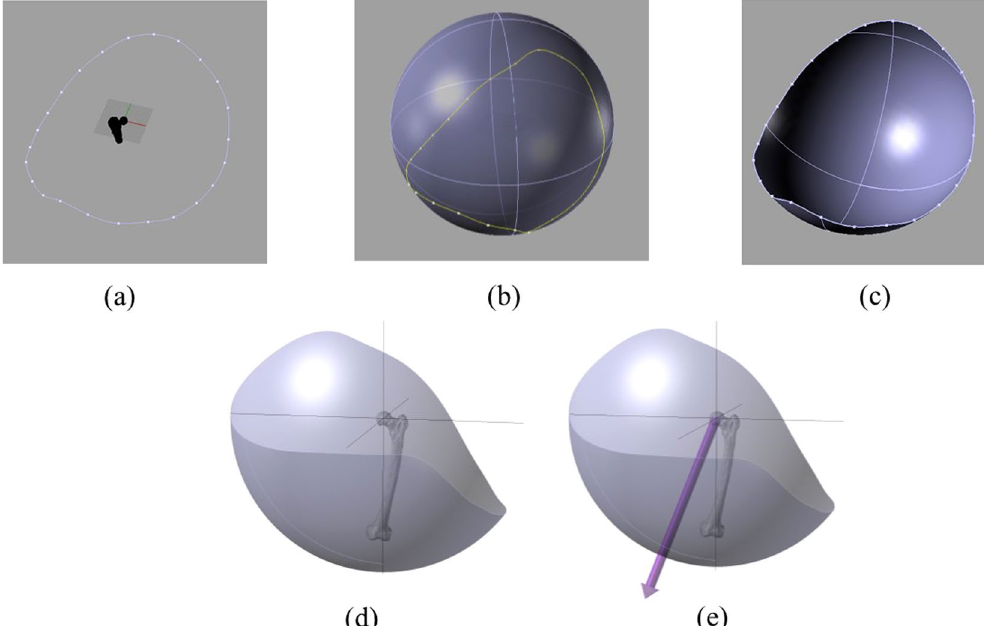
Figure 3. Schematic representation of the modelling procedure to construct subject-specific post-operative ROM area. ( a ) A set of collision points represents ROM boundary, ( b ) A sphere containing the ROM boundary. Centre of the sphere is the centre of rotation of ROM simulation and radius is the distance between the centres of rotation to the knee centre. ( c ) ROM area. ( d ) ROM area in another view. ( e ) Directional axis for prosthetic ROM